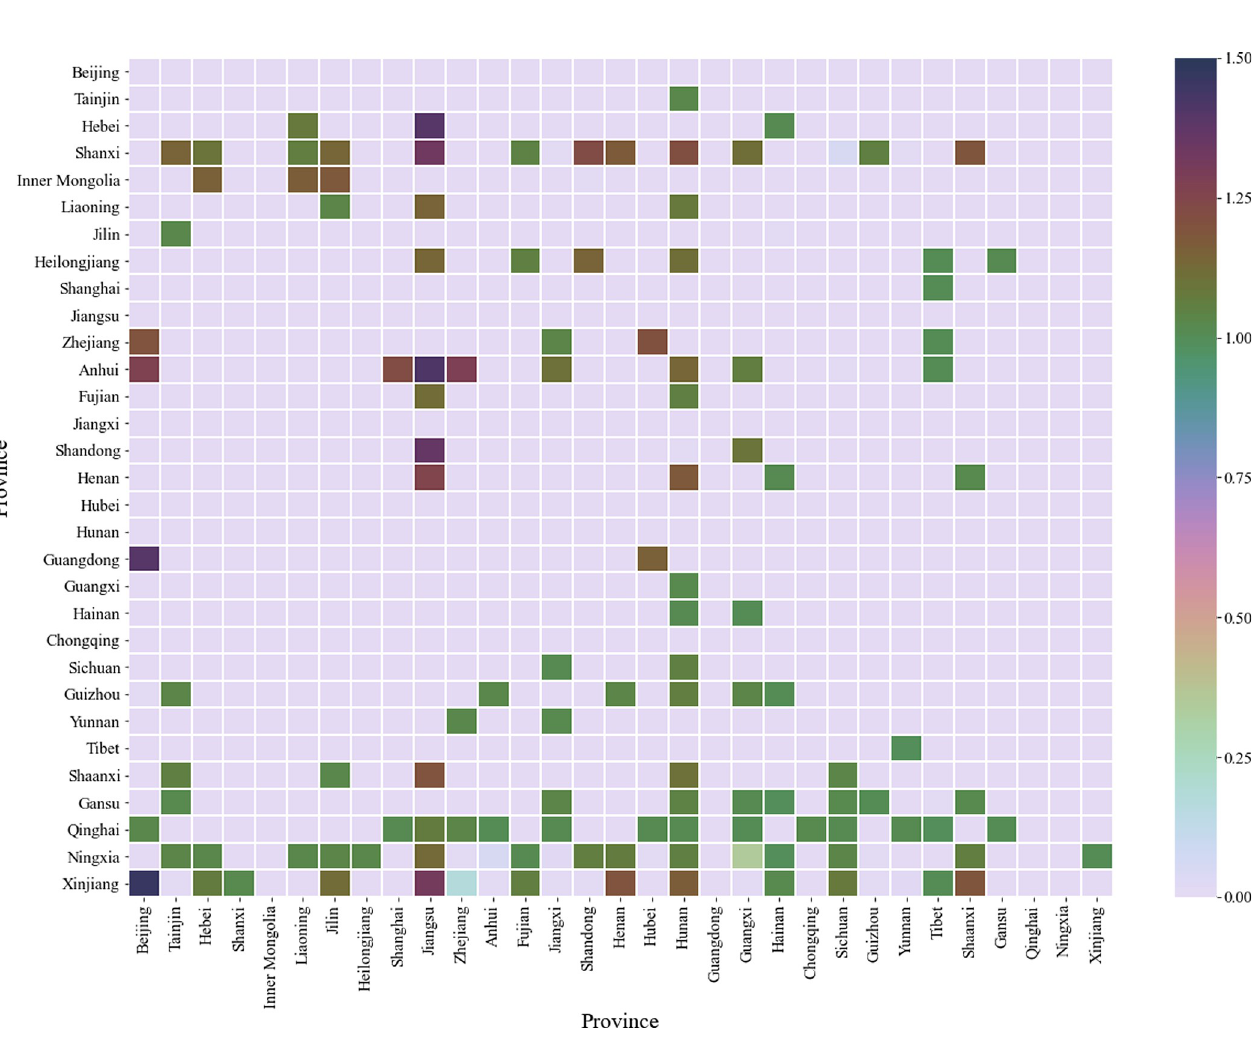
Fig 4. The matching degree of embodied carbon trade and value-added trade among31 provinces in China in 2015.